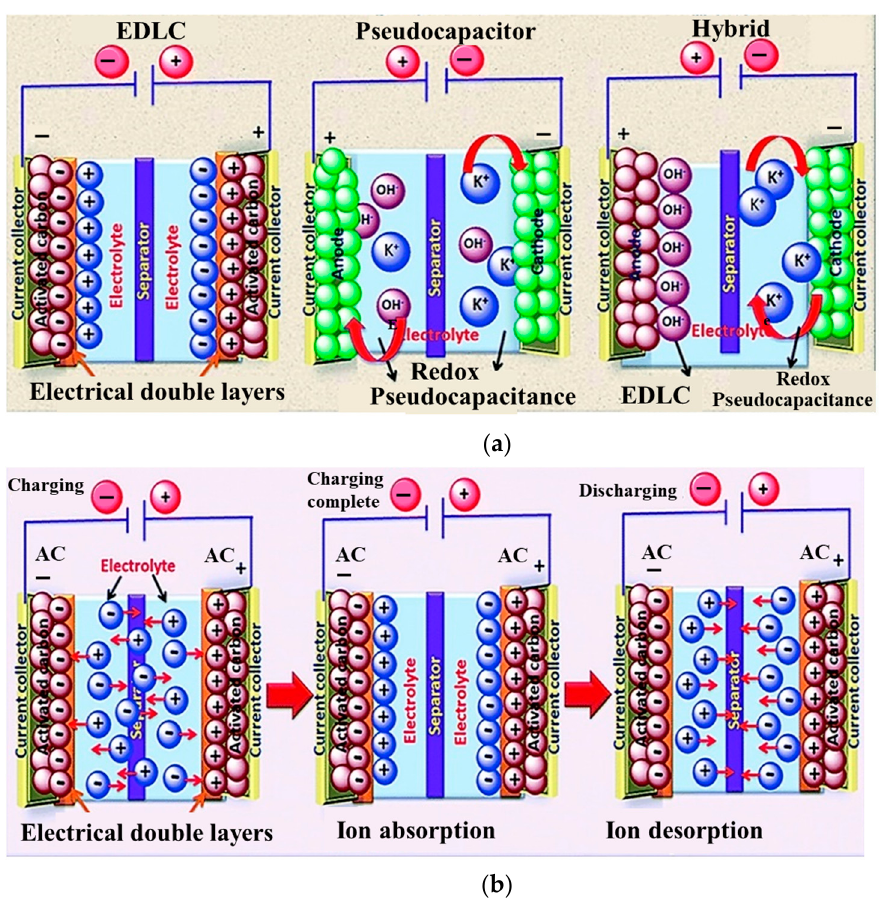
Figure 2. ( a ) Schematics of various types of capacitors. ( b ) Charge and discharge energy storage principles of an EDLC where black arrows represent ions in the electrolyte and red arrows reflect the direction of ion movement [45], open access